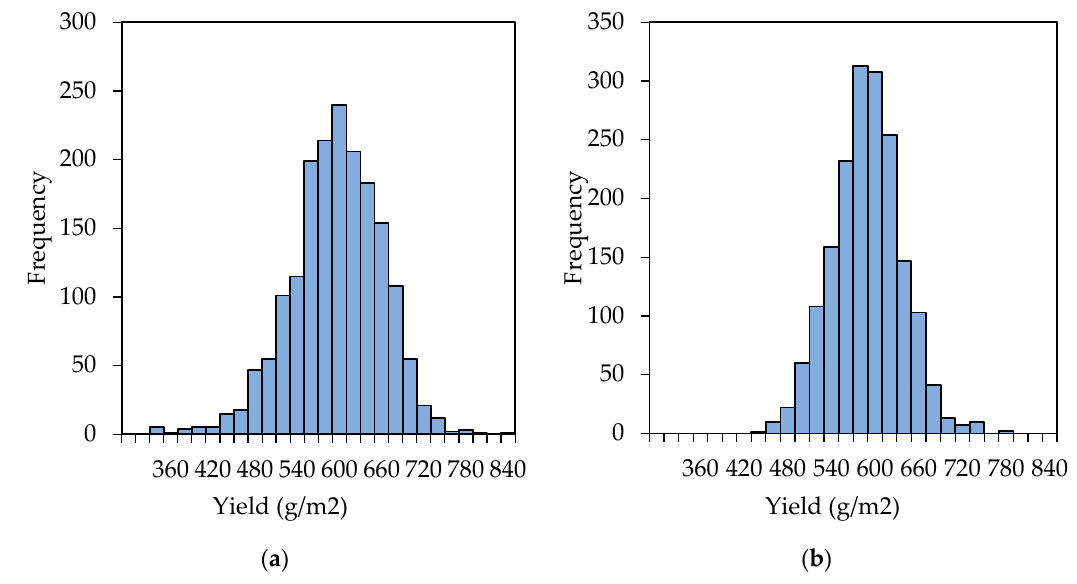
Figure 15. Histograms of harvester measured ( a ) and estimated ( b ) winter wheat yield for S2.